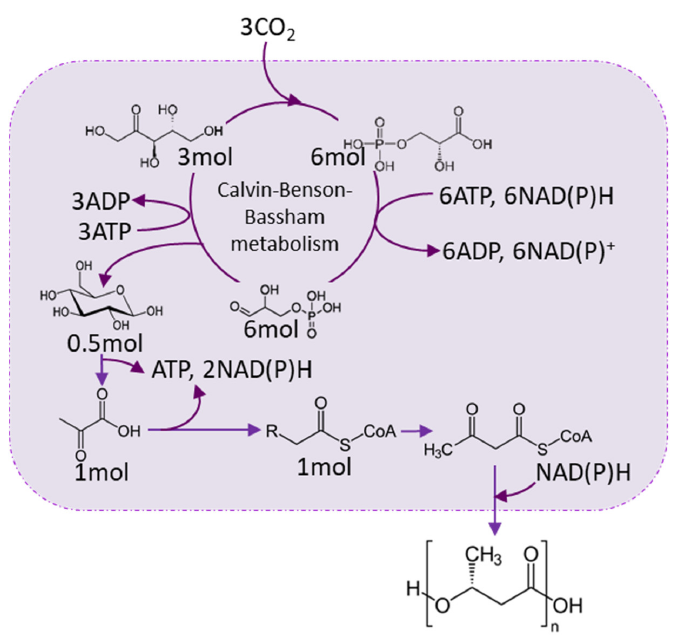
Figure 4. Calvin–Benson–Bassham autotrophic metabolism and simplified glucose metabolism to PHB synthesis via glycolysis and acetyl-CoA.